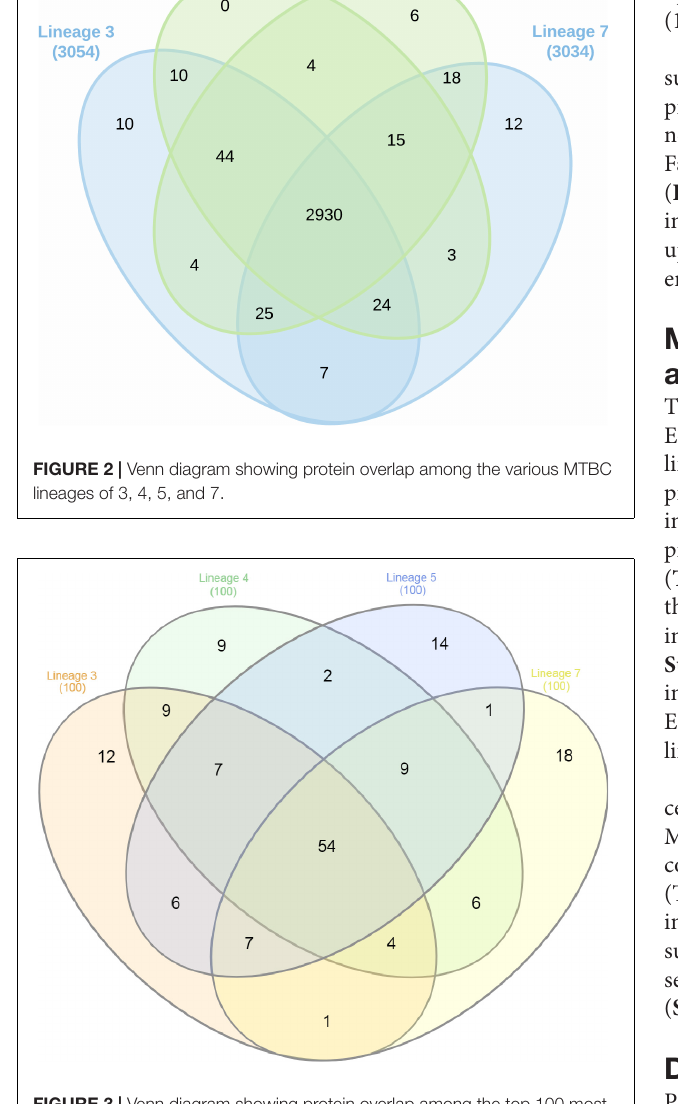
FIGURE 3 | Venn diagram showing protein overlap among the top 100 most abundant proteins identified in the MTBC lineages of 3, 4, 5, and